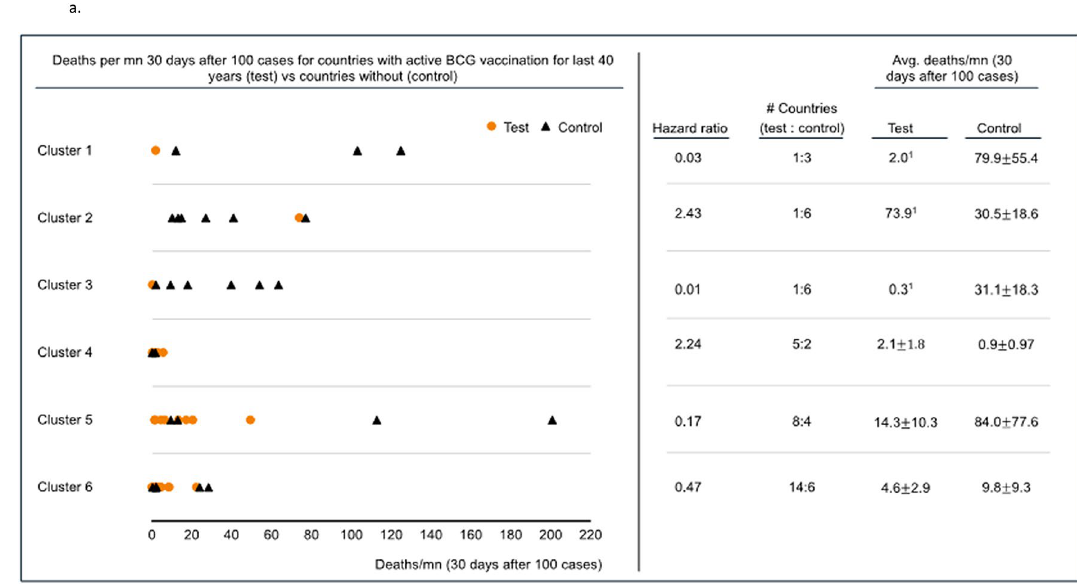
Figure 2. ( a ) Deaths per million 30 days after 100 cases were reached for countries with an active BCG vaccination program for the 15 years preceding the pandemic (Test) vs countries without BCG vaccination programs (Control). Cluster 4 contains no comparator and CRM was generally low. The results in cluster 2 are possibly driven by Ireland which has endured significant CRM among at risk populations. ( a ) and ( b ) were created using R Studio for windows (1.3.1093) at https ://rstud io.com/; R for windows (4.0.3) at https ://www.r- proje ct.org/; and Microsoft Powerpoint Version 2008, Build 13127.20760. URL—https ://www.micro soft.com/ en-in/. ( b ) Deaths per million 30 days after 100 cases were reached for countries with an active BCG vaccination program for the 40 years preceding the pandemic (Test) vs countries without BCG vaccination (Control). The results in cluster 2 are possibly driven by Ireland which has endured significant CRM among at risk